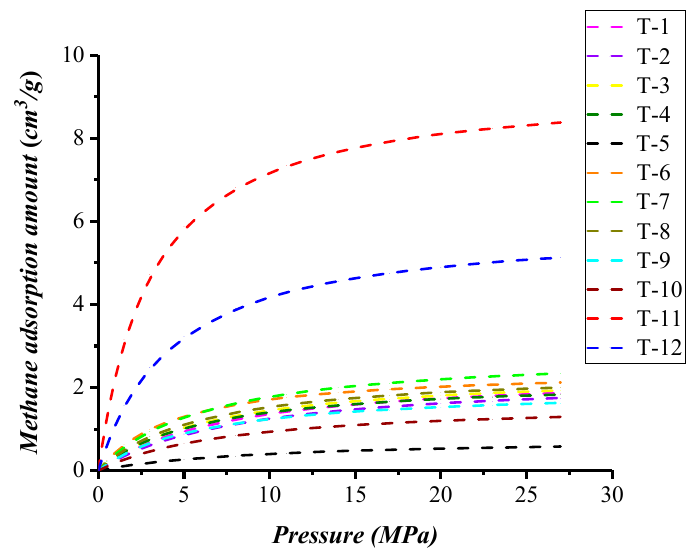
Figure 8. Langmuir isotherms for absolute adsorption of methane at 55 °C in the 12 shale samples.